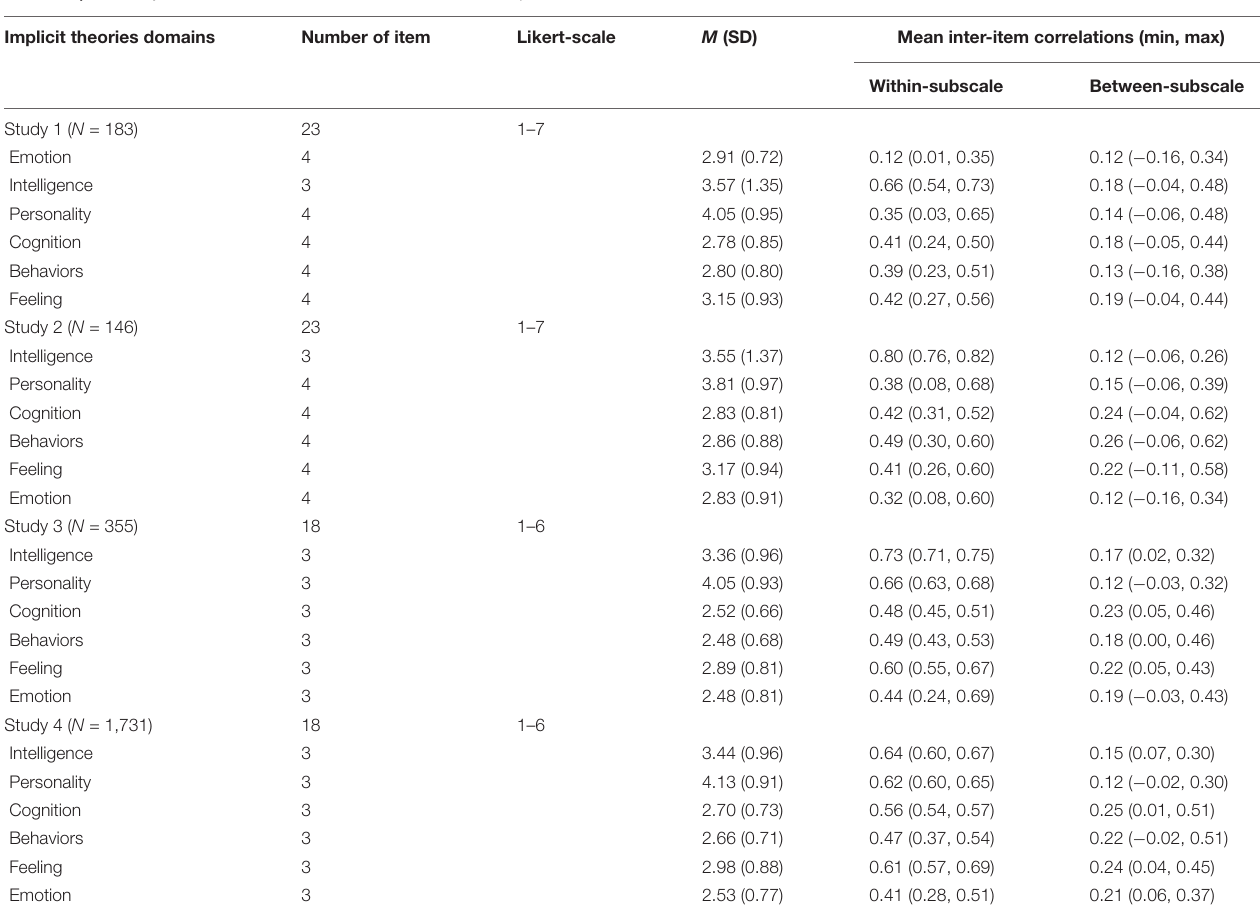
TABLE 2 | Summary statistics and mean inter-item correlations of implicit theories